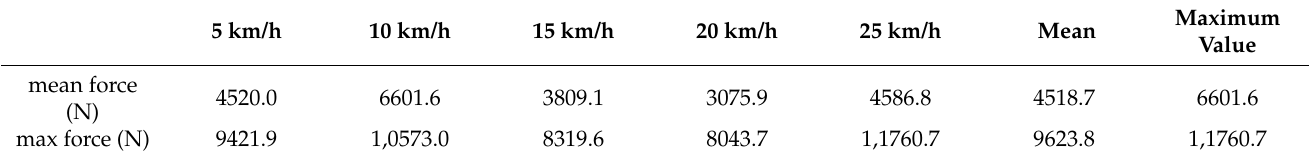
Table 5. Statistical characteristic table of the 10 m span contact force curve.